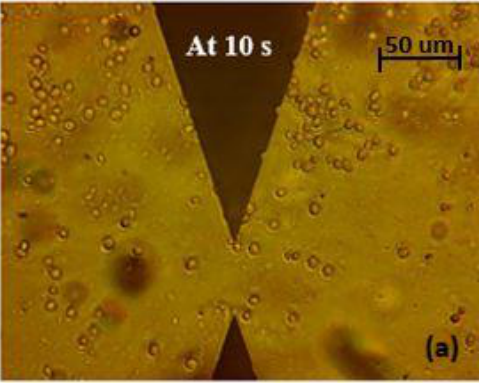
Figure 2. The uniform distribution of particles in a mixture of yeast cells and Aβ before applying dielectrophoresis (DEP) force.